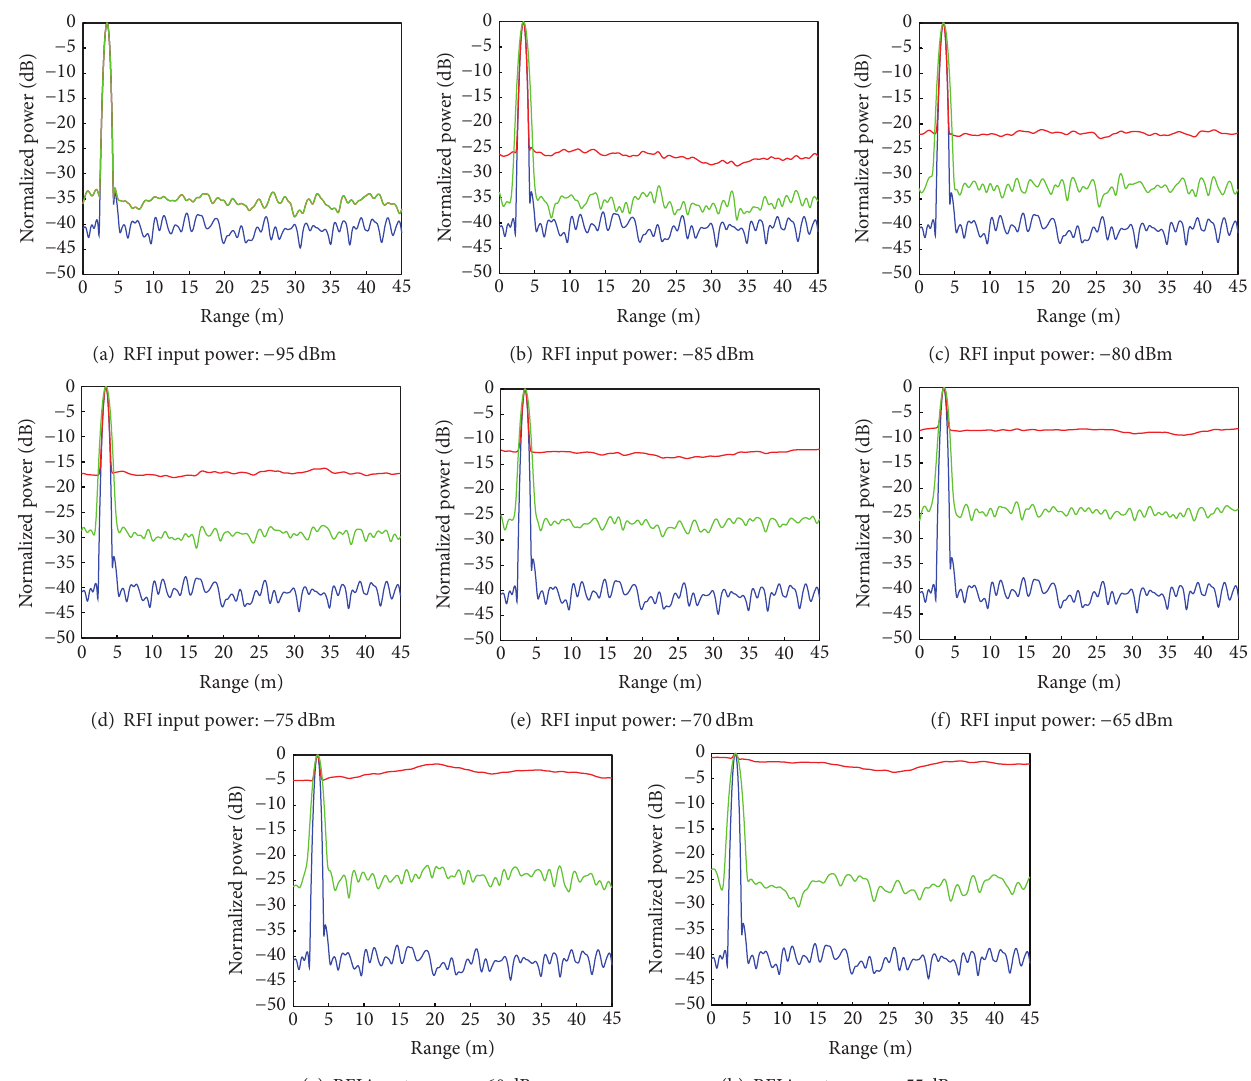
Figure 8: Range profiles for the narrowband RFI experiment. As shown, the narrowband RFI significantly increases sidelobe power as compared to the sidelobe power generated by the SS-MO technique (due to the reduced bandwidth).